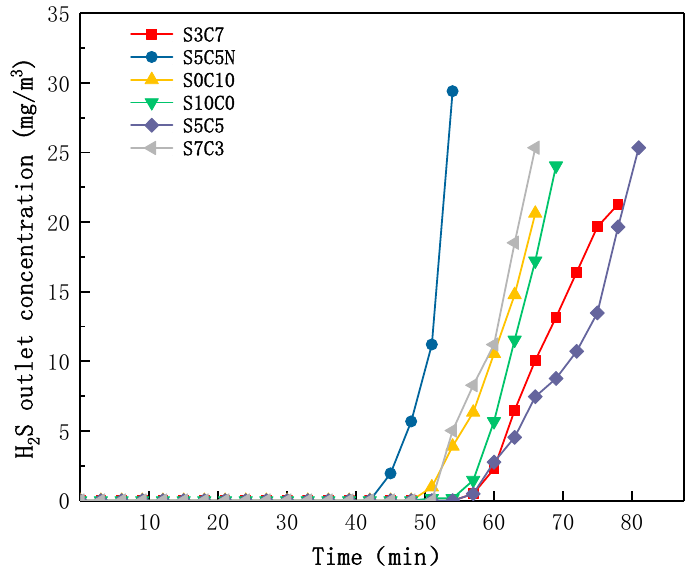
Figure 5. The breakthrough curves of hydrochar S5C5 with different molar ratios of chitosan to starch (T, 230 °C; auxiliary agent, cationic PAM; cationic PAM concentration, 2.0 g/L).